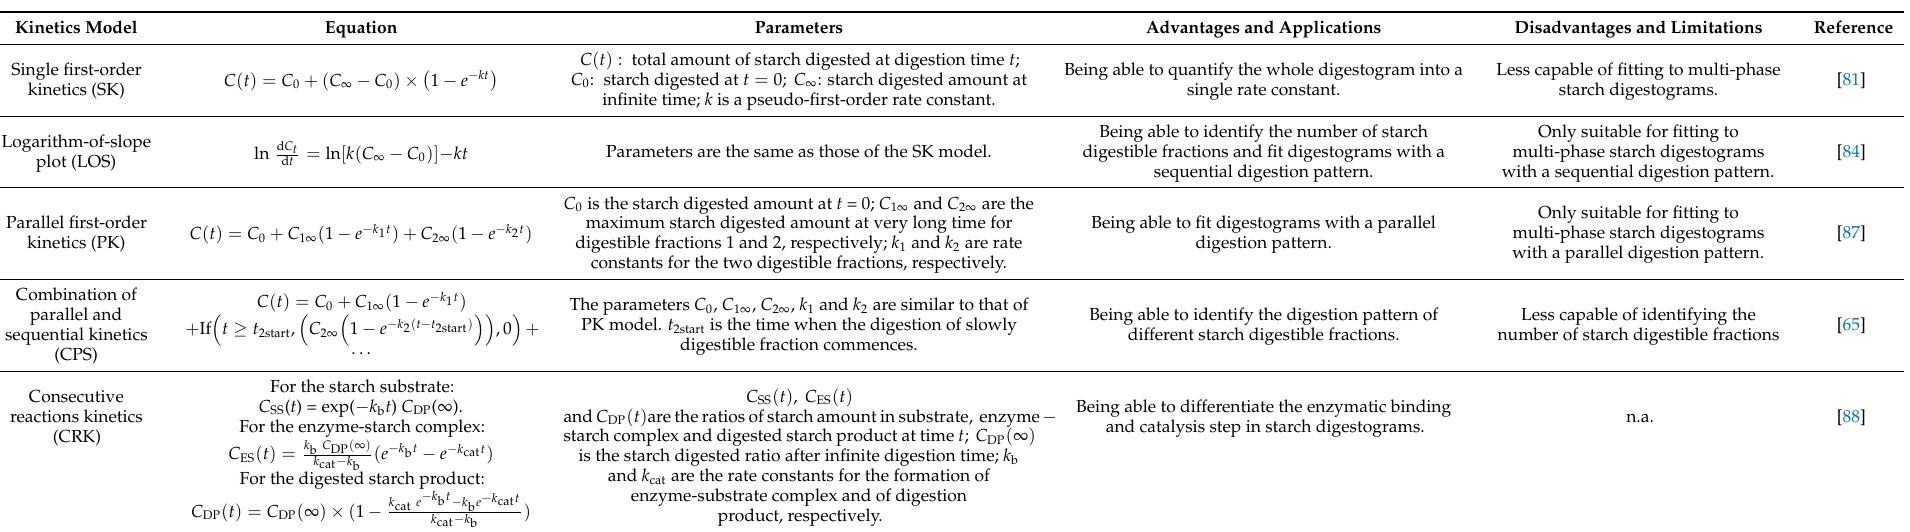
Table 3. Kinetics models for understanding starch digestion